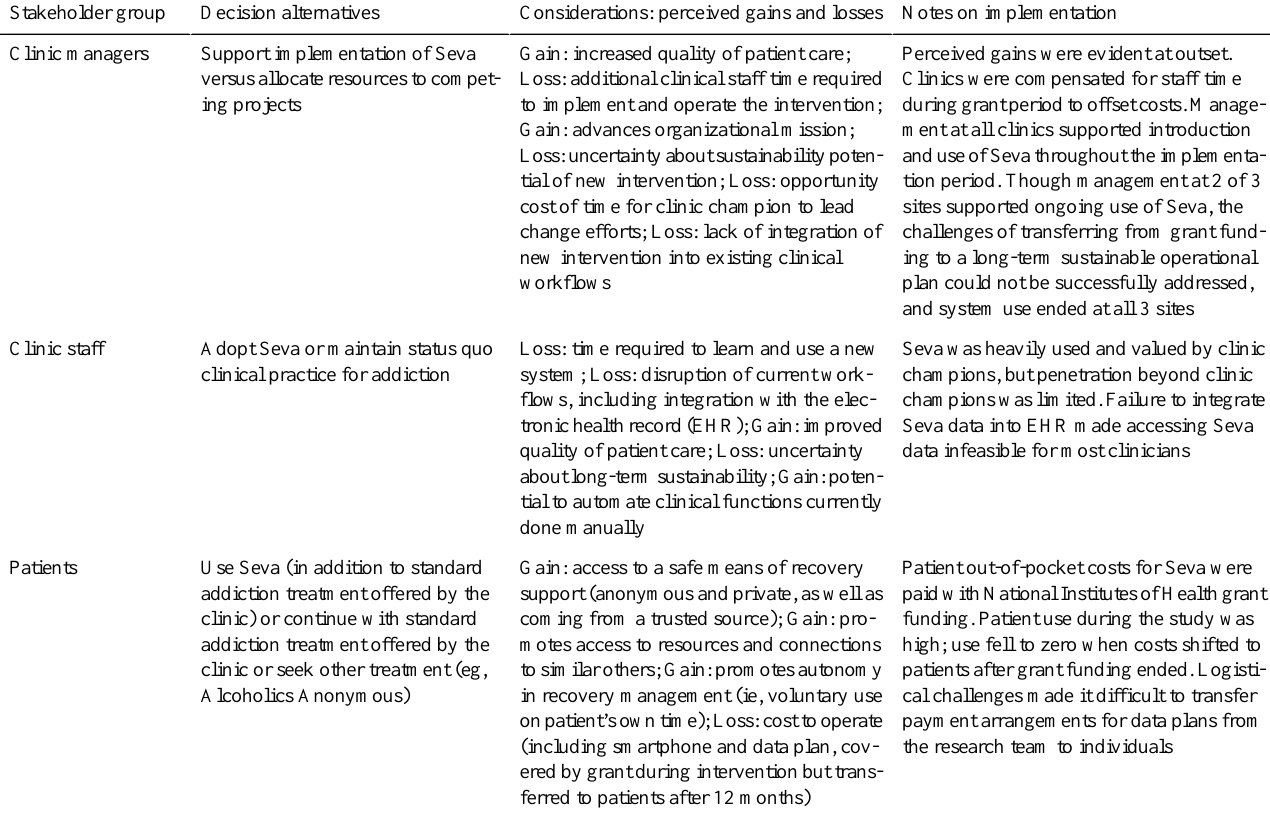
Table 2. Stakeholder implementation